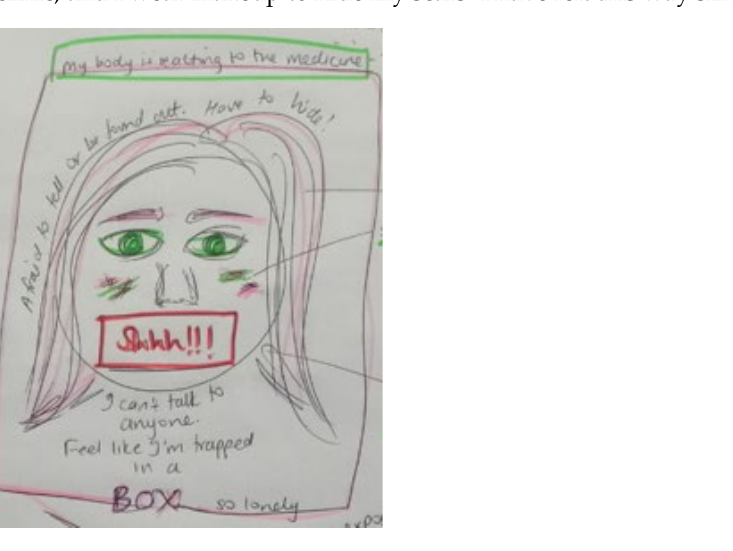
Figure 10. Bodily changes, internal stigma, and suicidal ideation. Figure 11: Romantic partnerships